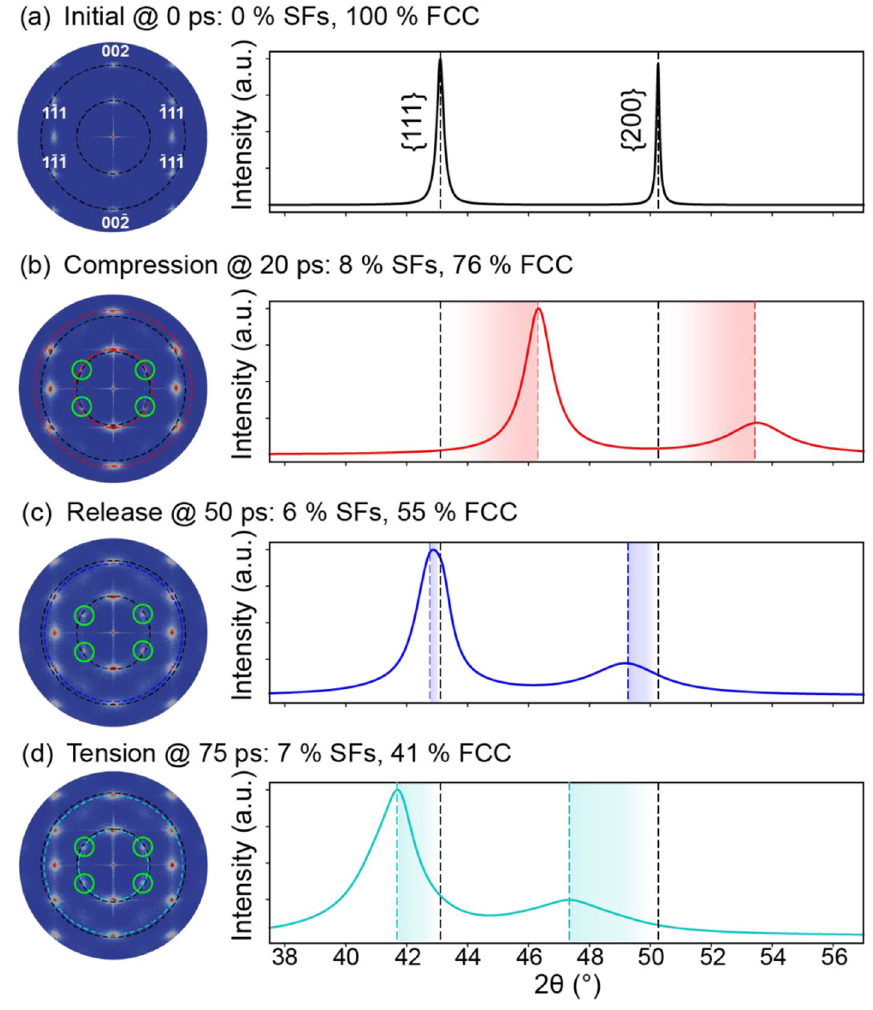
Figure 9. Virtual diffraction for FCC Cu shocked along [111] at ( a ) 0 ps, ( b ) 20 ps, ( c ) 50 ps, and ( d ) 75 ps after impact. Each SAED corresponds to a [110] zone axis, a 1.25-Å −1 radius, and 200-keV electron irradiation. Each XRD represents powder diffraction for Cu-Kα X-rays. For association with diffraction signatures, discrete quantifications of stacking faults (SFs) and phases are provided in the subfigure labels. For reference, new SAED spots are indicated with solid circles, and the locations of SAED spots and XRD peaks are indicated by dotted lines color-coded by time step. The SAED spots for low-order planes are indexed. SAED patterns are plotted using Paraview 66 , version 5.7 from https:// www. parav iew.